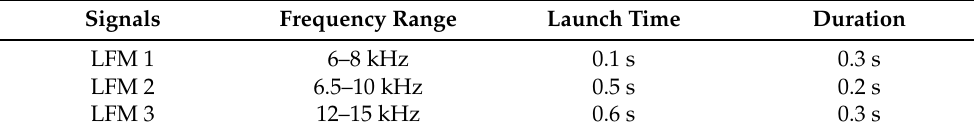
Table 3. LFM signal parameters for binary time–frequency masking method